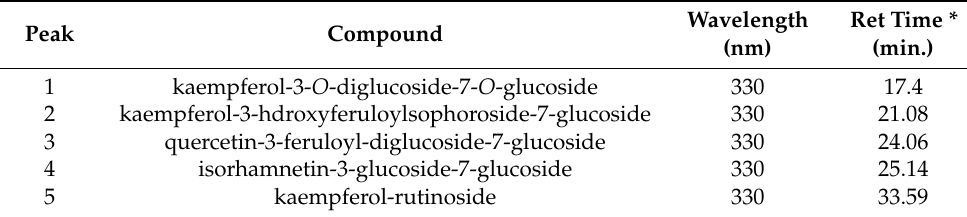
Table 3. Polyphenols identified in Brassica raimondoi leaf extract by HPLC-DAD. Peak